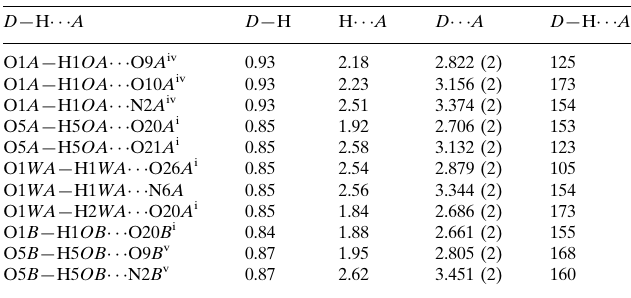
Hydrogen-bond geometry (A˚ , (cid:2)